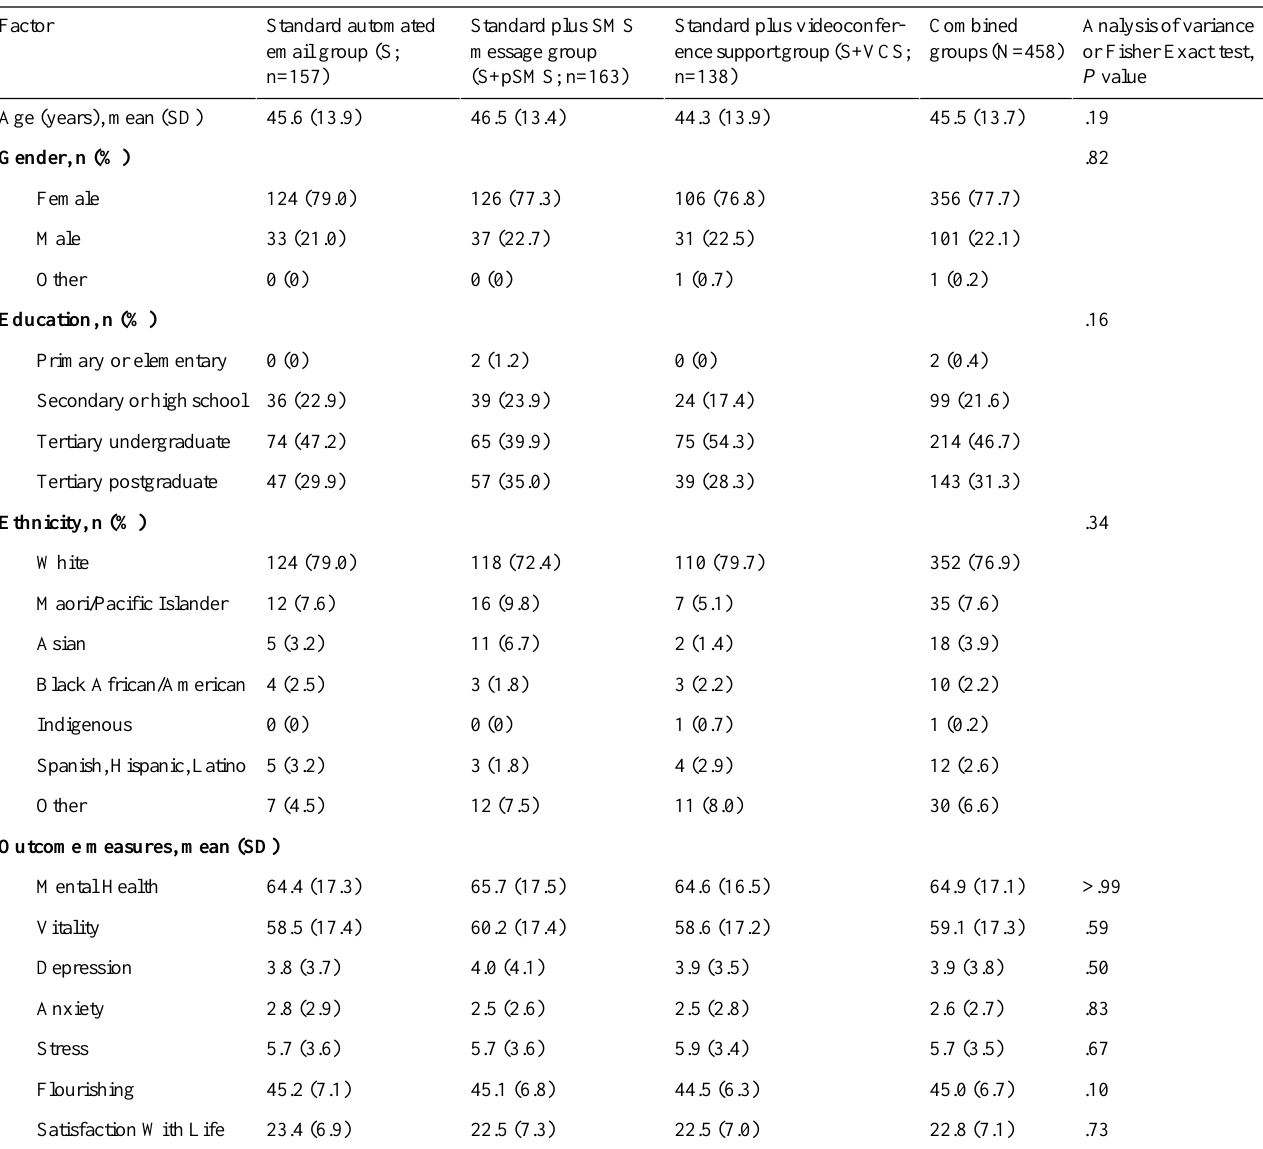
Table 2. Baseline characteristics of the study population.